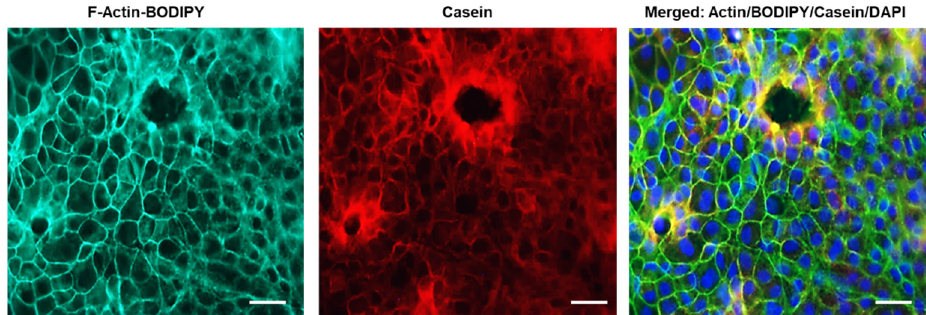
Figure 2. Milk Protein β -casein in Mice Mammary Epithelial Cultures (MEC). Immunostained im- ages of F-actin (green) as a marker of epithelial cells and β -casein (red) as a marker of milk and merged image. Blue represents the nuclei stained with DAPI. Scale bars are 20 μ m.